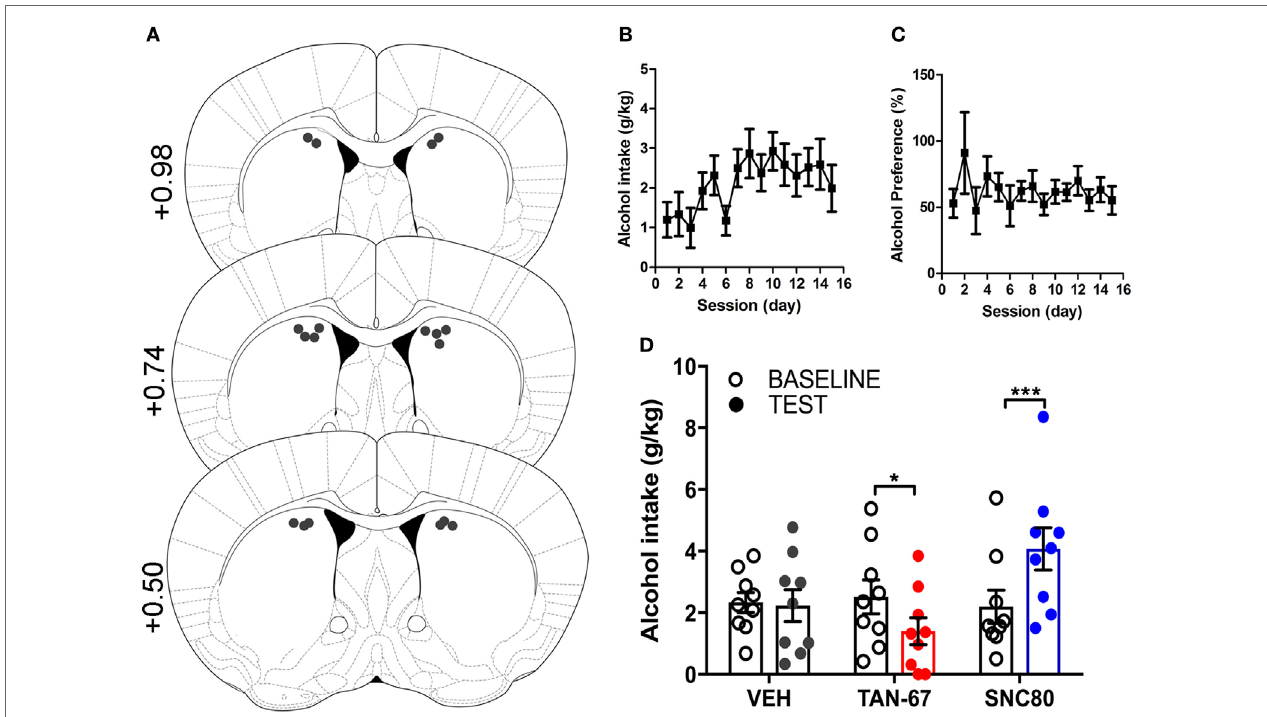
FigUre 4 | Dorsal striatal infusion of G i/o -protein biased delta-opioid receptor (DOR) agonist TAN-67 decreases voluntary alcohol intake, while β -arrestin-2 biased DOR agonist SNC80 increases alcohol intake in wild-type mice. Cannula placement was verified for all animals included in behavioral analysis (a) . C57BL/6 male, wild-type mice ( n = 9–10) were trained to consume 10% alcohol over the course of 3 weeks, during which they increased their alcohol intake (B) and alcohol preference (c) . Vehicle saline (0.9%) infusion did not change alcohol intake while TAN-67 (10 µM) significantly decreased alcohol intake and SNC80 (10 µM) significantly increased alcohol intake (D) . Significance by repeated measures, multiple comparisons (Tukey) two-way ANOVA, * p < 0.05 and *** p <